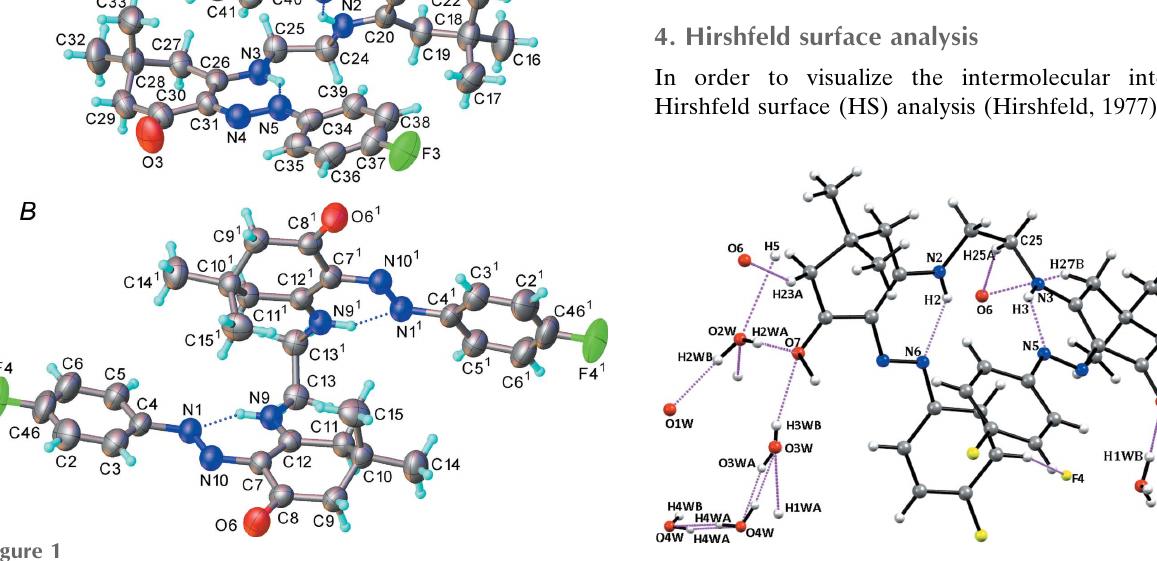
Figure 2 Hydrogen bonds in the crystal of (II).